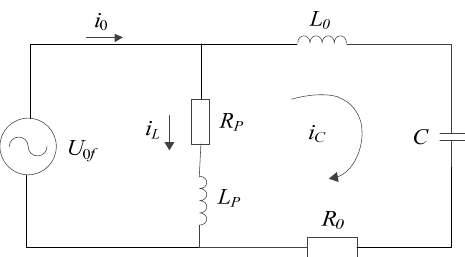
Figure 1. Transient equivalent circuit for the single-phase ground (SPG) fault.